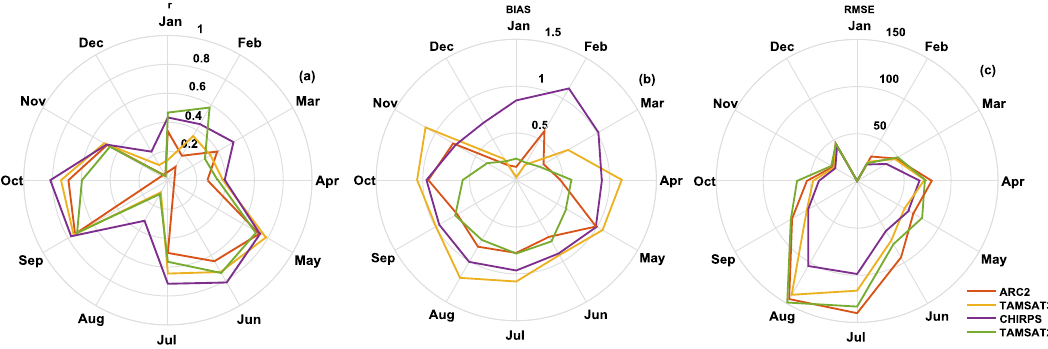
Figure 10. Statistical validation of the satellite products for each month of the Upper Blue Nile basin for the period of 2000–2015: (a) Pearson correlation coefficient ( r ), (b) bias ratio, and (c) the root mean square error (RMSE). The RMSE values are shown in millimeters.